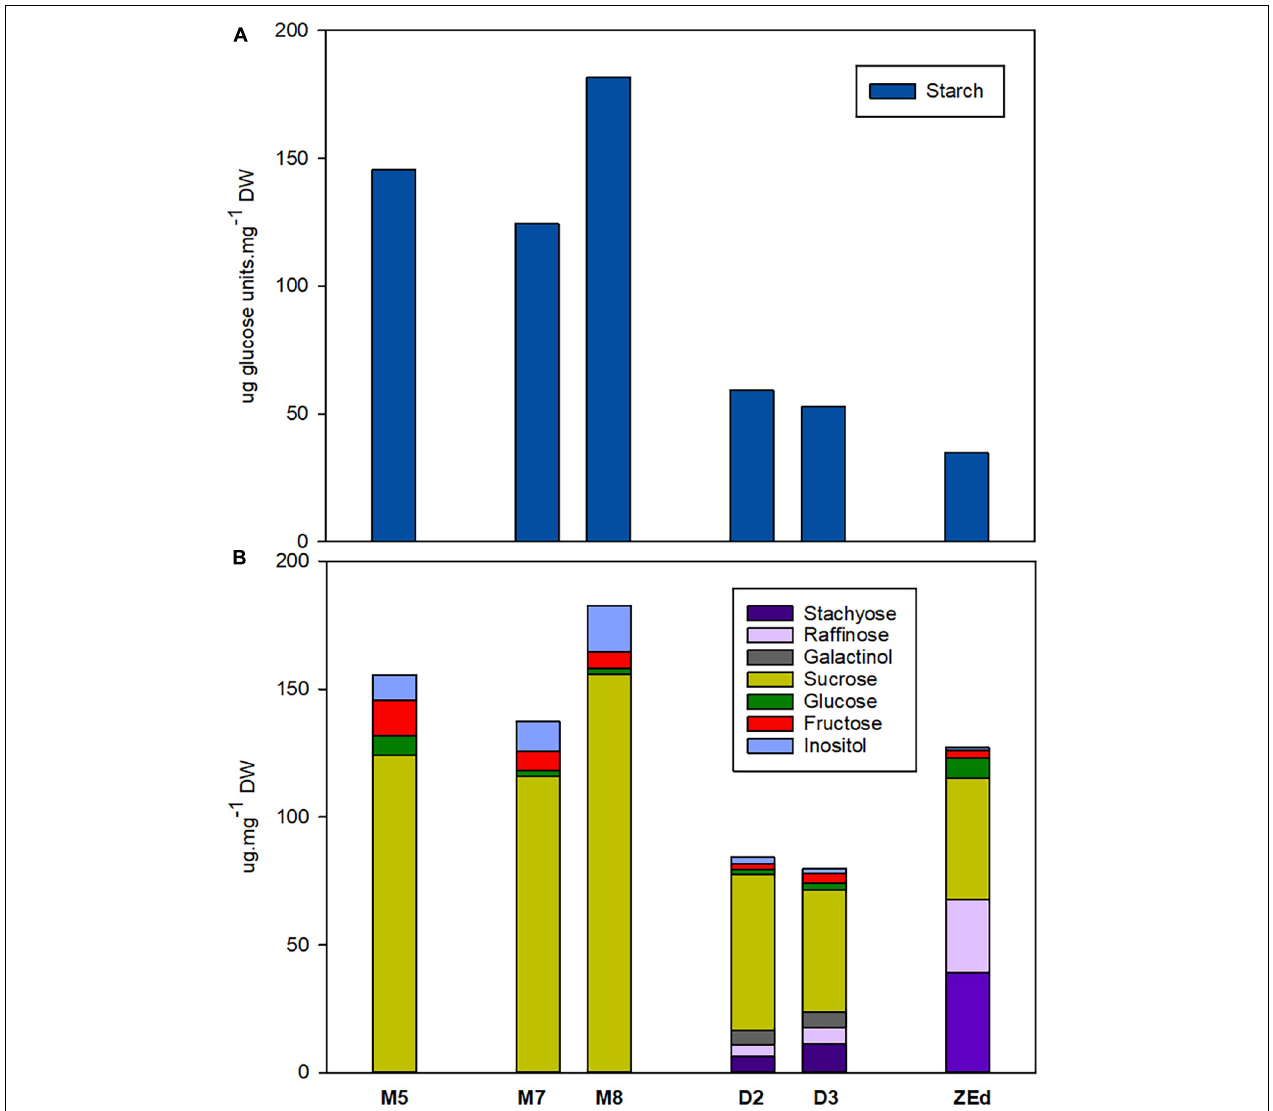
FIGURE 5 | Endogenous non-structural carbohydrates in P. abies somatic (SEs) and zygotic (ZEs) embryos. (A) Starch content (expressed as glucose amount after enzymatic starch cleavage); (B) Soluble carbohydrate content and spectrum. M5 – mature SEs after 5 weeks of maturation, M7 and M8 – SEs after 7 and 8 weeks of prolonged maturation, D2 and D3 – SEs after 2 and 3 weeks of desiccation, ZEd – dry ZEs; n = 4–6. Components of carbohydrate spectrum that accounted for less than 1% of the total carbohydrates are included only in Supplementary Table 1